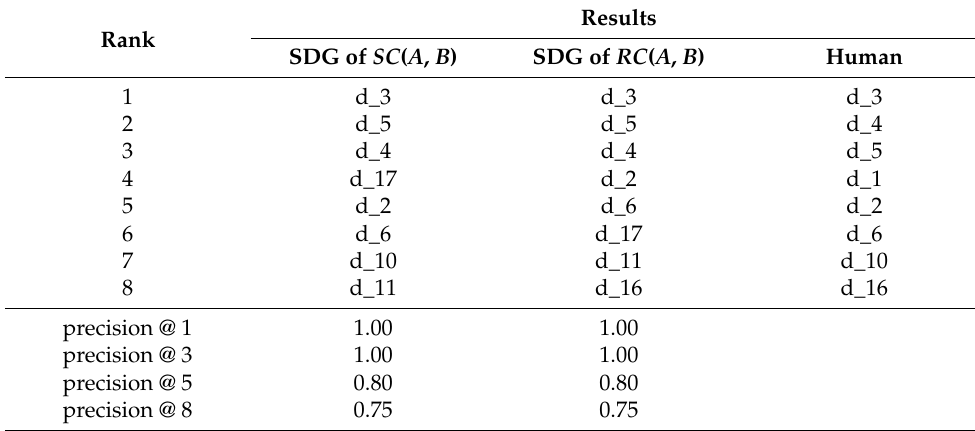
Table 4. Ranking results of Models SC ( A , B ) and RC ( A , B ) as well as human evaluation for low cognitive diversity case: CD ( A , B ) = 0.08.